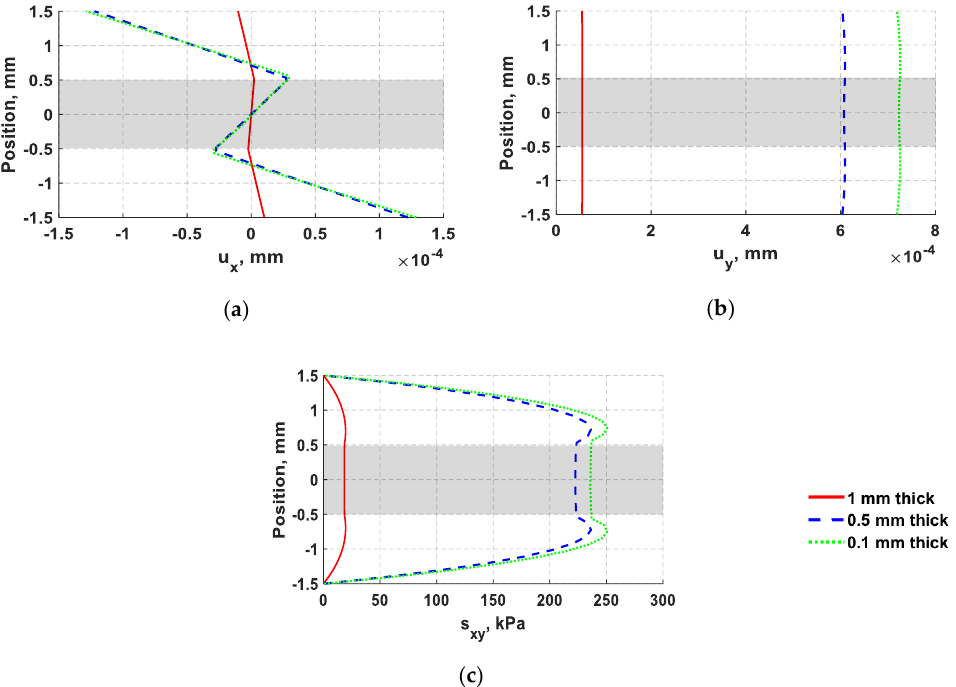
Figure 14. Comparison of through thickness displacements and in-plane stresses of flexural waves at 30 kHz with varying the thickness of d35 PZT transducers as follows: 1 mm (red solid line), 0.5 mm (blue dashed line), and 0.1 mm (green dotted line). ( a ) Axial (x) displacement; ( b ) lateral (y) displacement; ( c ) in-plane shear stress.